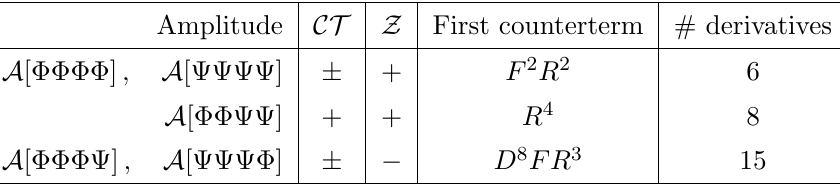
Table 7 . Four particle scattering in N = 6 supergravity. The dimension is the mass dimension of the lowest bulk counterterm contributing to the amplitude, and CT and Z are the discrete symmetries de(cid:12)ned in the main